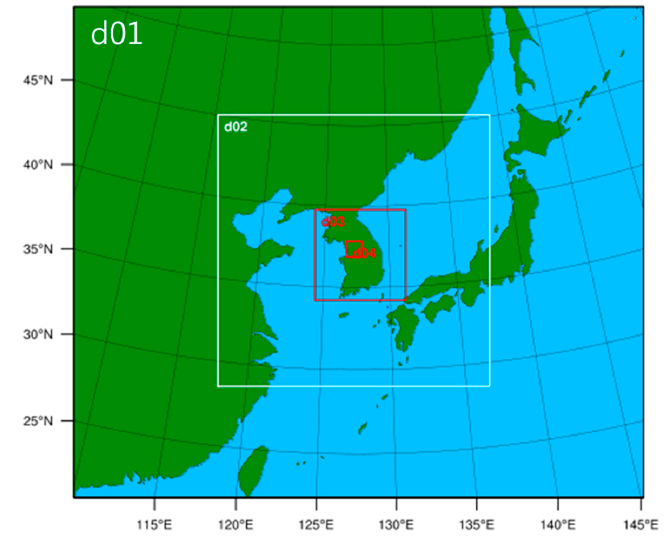
Figure 1. National Center for Agro-Meteorology (NCAM)–Land Atmosphere Modeling Package (LAMP) Weather Research and Forecasting (WRF)/ Noah-Multiparameterization (Noah-MP) model (version 1.5) domains.